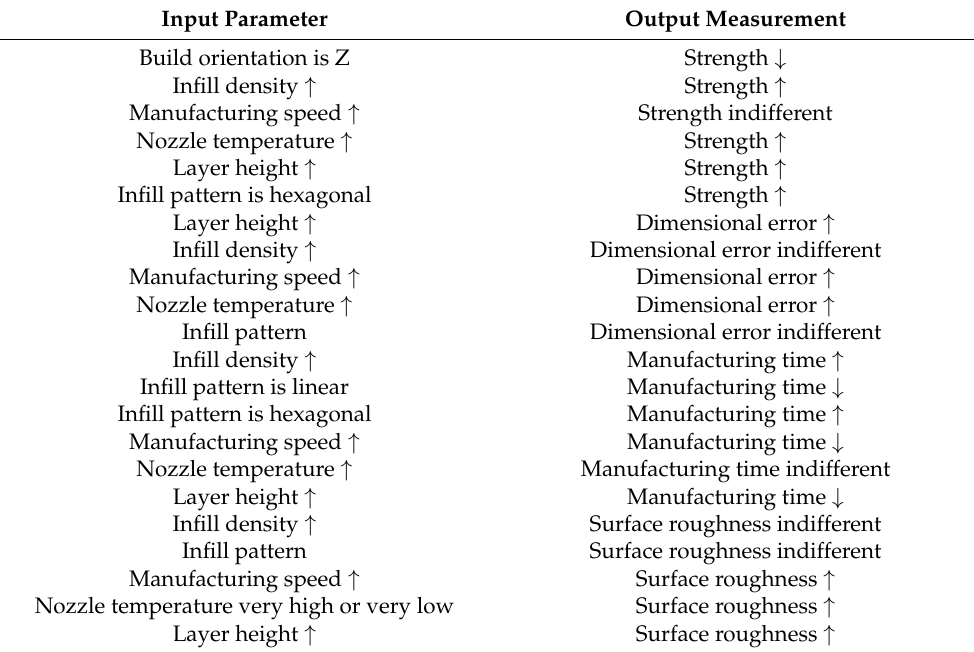
Table 1. Correlations used to create synthetic data on influence of FDM process parameters. ↑ indicates increase, ↓ indicates